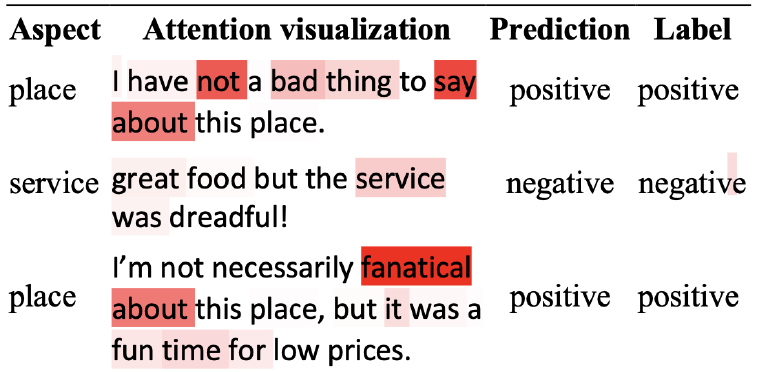
Figure 5. Case study. Visualization of attention scores for Rest14, Rest15, and